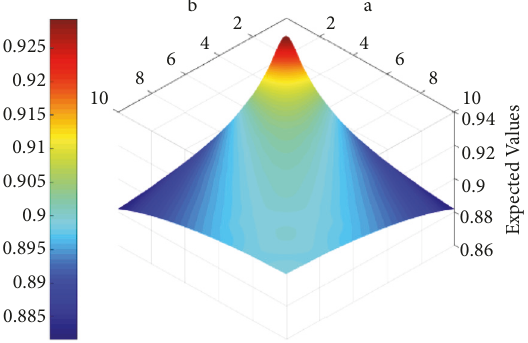
̃̃1) Figure 6: 𝐷(𝑅 4 − of Α 4 based on IT2FWPHM operator.